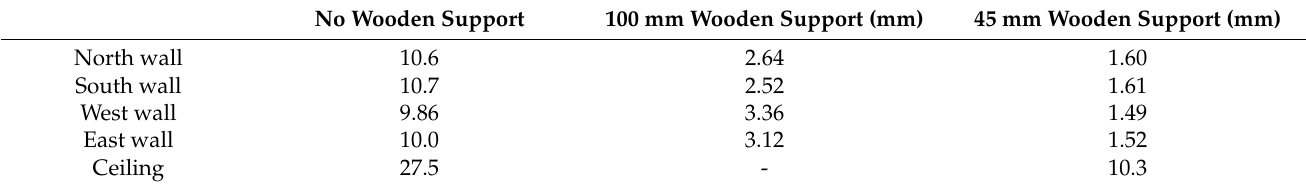
Figure 5. Structure of the inner wall and ceiling: ( a ) schematic horizontal section of the inner wall; ( b ) schematic vertical section of the ceiling. Table 2. The area of the wall part without, with 100 mm, and with 45 mm thick wooden support (m 2